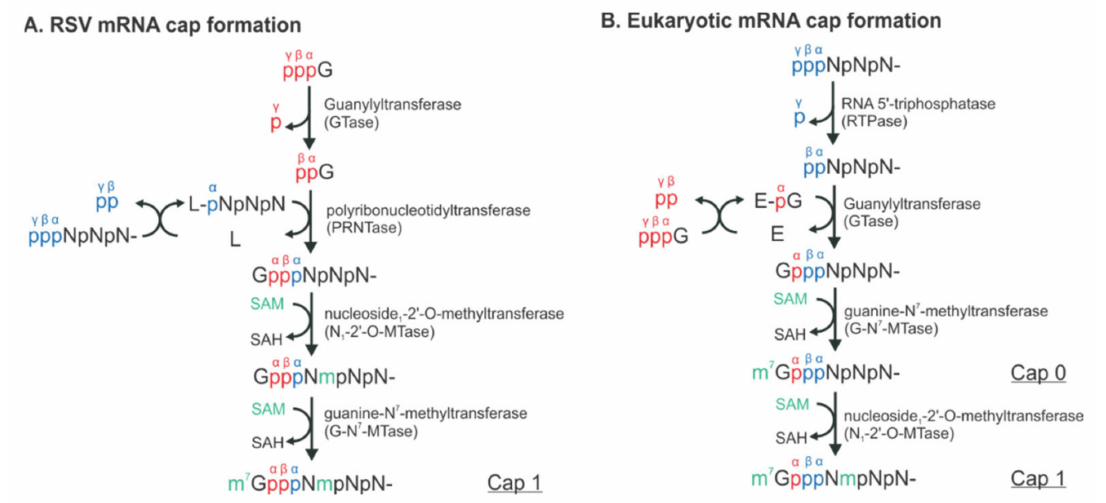
Figure 2. The distinct mechanisms of the RSV and eukaryotic mRNA cap formation. The schematical comparison of the unconventional ( A ) and conventional ( B ) pathways. The pre-mRNA, GTP, and S-adenosyl-L-methionine (SAM) are highlighted in blue, red, and green, respectively. The α , β , and γ positions of the phosphates are indicated to illustrate the exact positions where the chemical reactions occur. N denotes any of the four nucleotides, A, U, G, and C. L denotes the large protein L in RSV. E denotes the enzyme, guanylyltransferase (GTase). Note that there is an L:RNA (L-pNpNpN) intermediate and the final mRNA cap products of both unconventional and conventional pathways are chemically